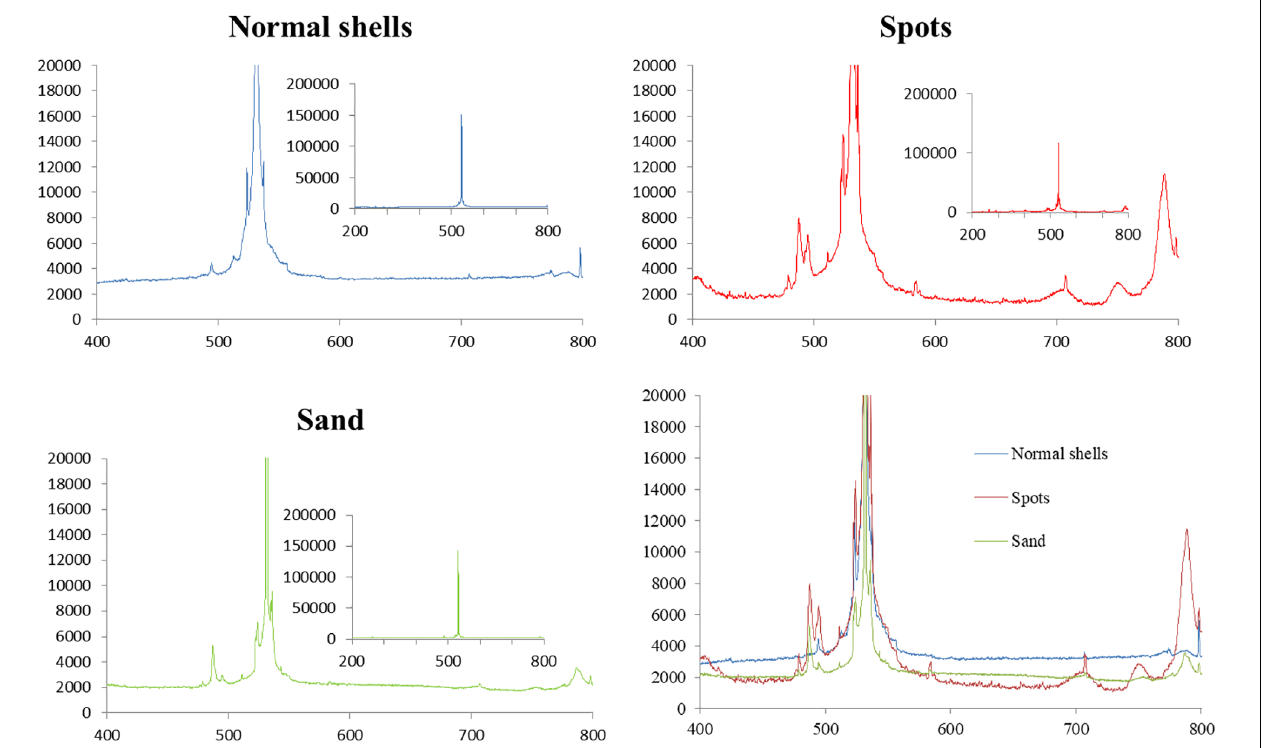
Frontiers in Marine Science |